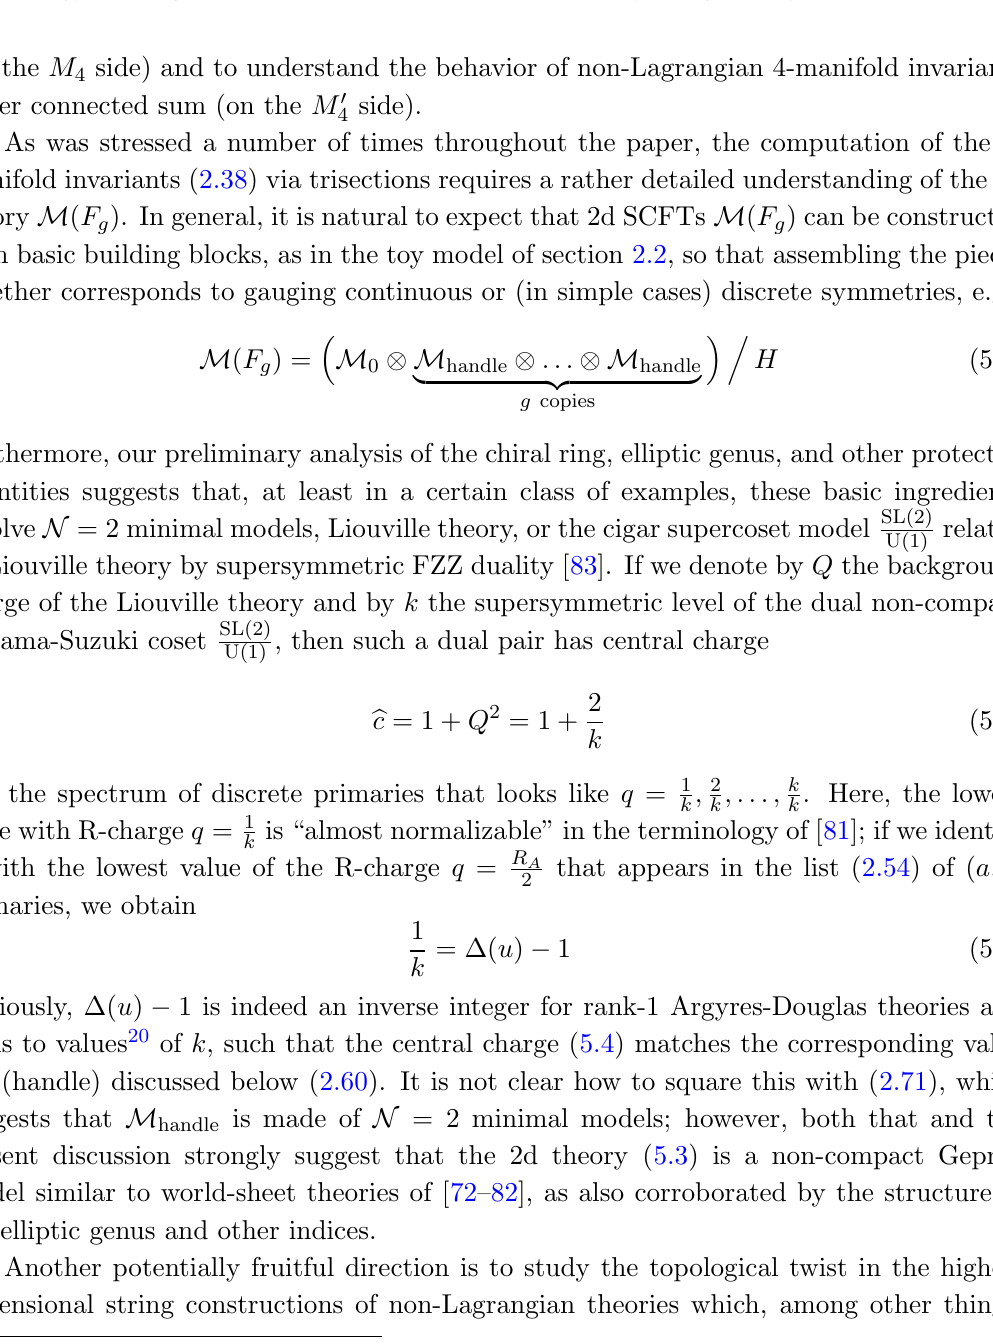
Table 8 . The virtual dimension \VirDim( M )" or, equivalently, \ghost number" anomaly (2.42) in rank-1 Argyres-Douglas theories on a 4-manifold M 4 de(cid:12)ned by a degree- d hypersurface in C P 3